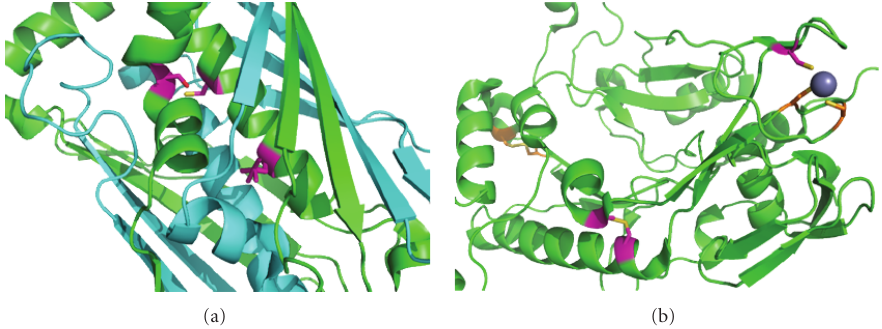
Figure 4: Examples of known thermophilic archaeal protein structures containing disulfide bonds, but having an odd number of total cysteines. Two proteins from Sulfolobus islandicus M.14.25 are shown. Mapped cysteines positions are represented in pink while cysteine residues involved in a putative metal-binding site are in orange, Zn in grey. (a) Mapping of an OsmC family protein (UniProtKB:C3MY18) onto the PDB structure 2OPL. One disulfide bond is predicted; the third cysteine is located at the surface and could participate in an intermolecular disulfide bond. (b) Mapping of a probable DNA primase small subunit (UniProtKB:C3MYF5) onto the PDB structure 1ZT2. Two mapped cysteines are poised to form a disulfide bond while the third is close to a Zn-binding site, suggesting an interaction with the metal ion. Many cases of proteins with an odd number of cysteines probably reflect the presence of intermolecular disulfide bonds or participation in metal-binding